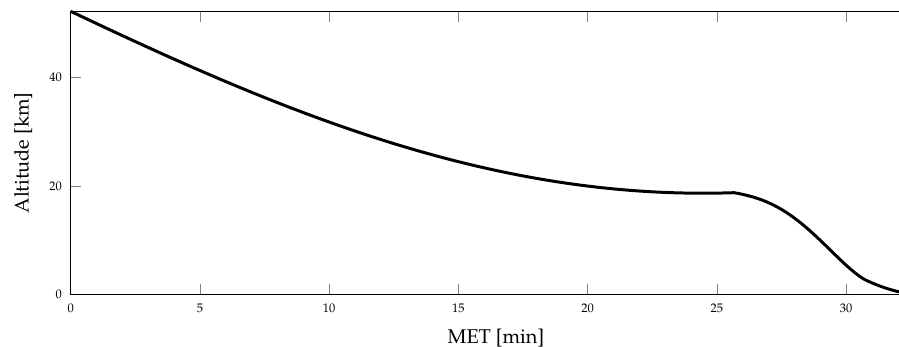
Figure 2. Vehicle altitude during terminal descent.